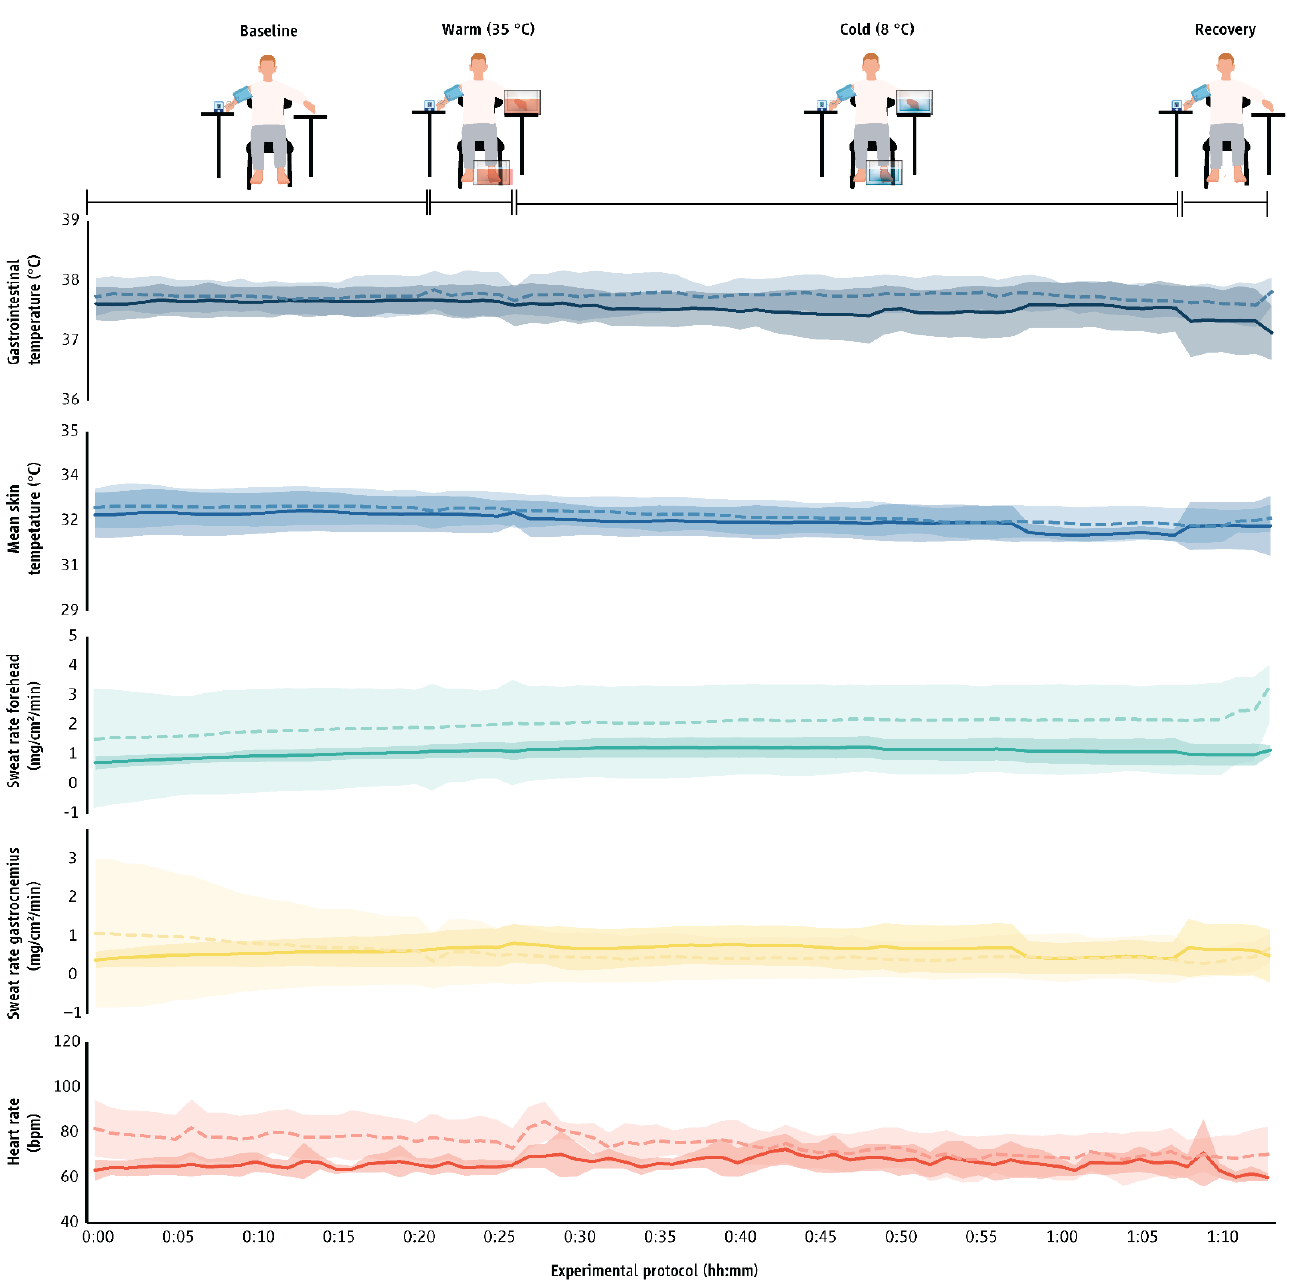
Figure A4. Physiological parameters (mean ± SD) during exposure to the thermoneutral environment (23 ± 1 °C) in the two groups. The first 20 min (00:00 to 00:20) indicate data collected during the baseline phase, the next five min (00:20 to 00:25) indicate responses during the warm-water immersion, the next 40 min (00:30 to 00:70) indicate responses during the cold-water immersion, and the final five min (00:70 to 00:75) show responses during the recovery phase. Continuous yellow lines indicate results for men participants and with dashed yellow lines present results for the women individuals.